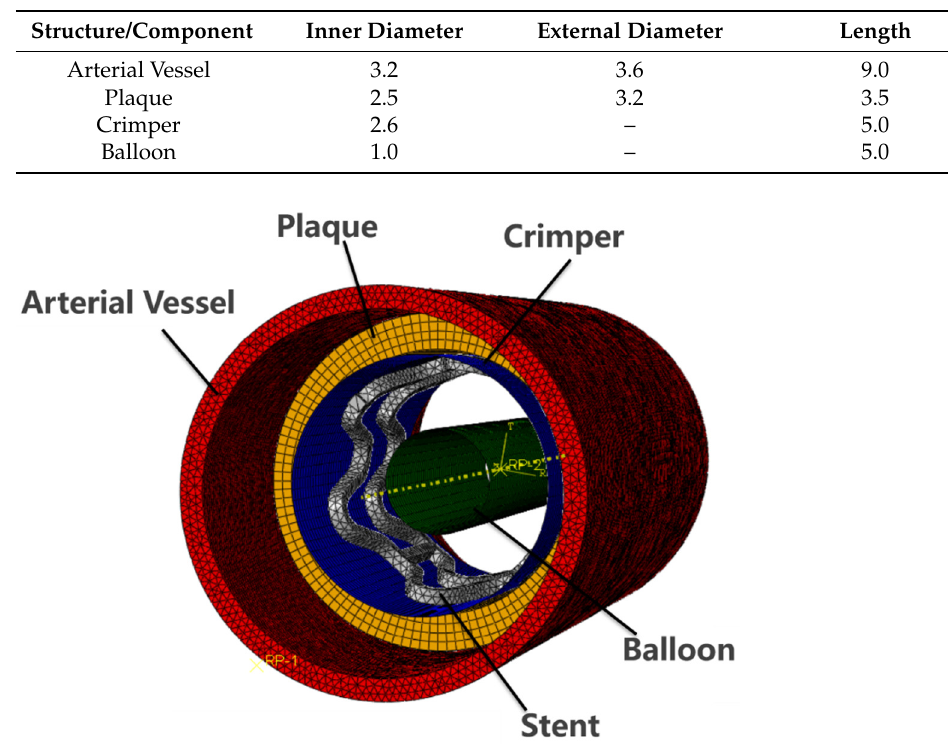
Table 3. Original dimensions for other geometric models (mm).